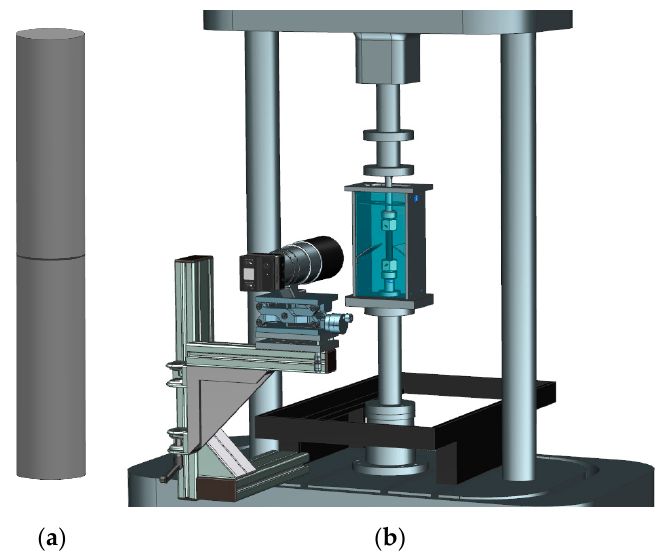
Figure 1. ( a ) Micro-sized specimens mounted on a unique device for immersion in chlorinated water; ( b ) illustration of the control scheme of the chlorinated water bath.